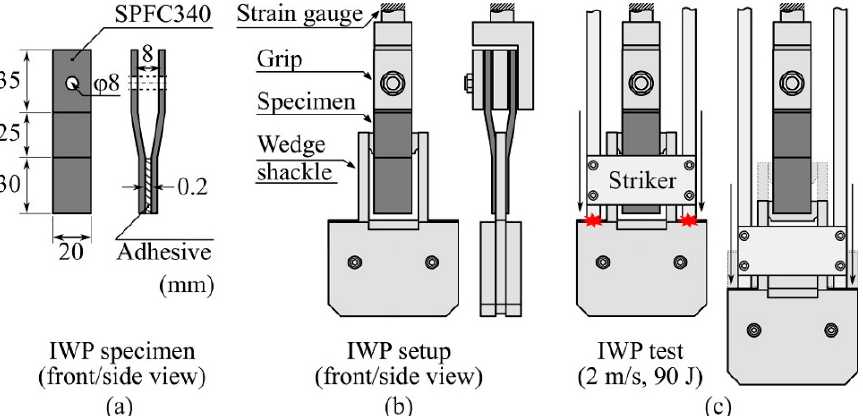
Figure 2. Schematic illustration of the ( a ) impact wedge-peel (IWP) specimen and dimension of each IWP adherend; ( b ) IWP setup in the drop tower chamber; ( c ) initial impact of the striker to the wedge shackle shoulder ( left ); and impact cleavage process ( right ) during the IWP test.